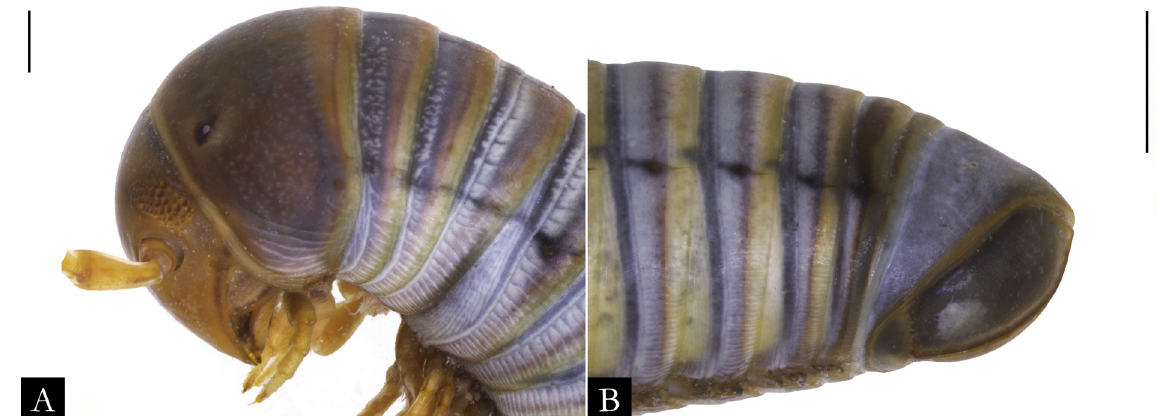
Fig. 113. Pseudonannolene robsoni Iniesta & Ferreira, 2014, ♂ (IBSP 3441), in lateral view. A . Anterior region. B . Posterior region. Scale bars = 0.5